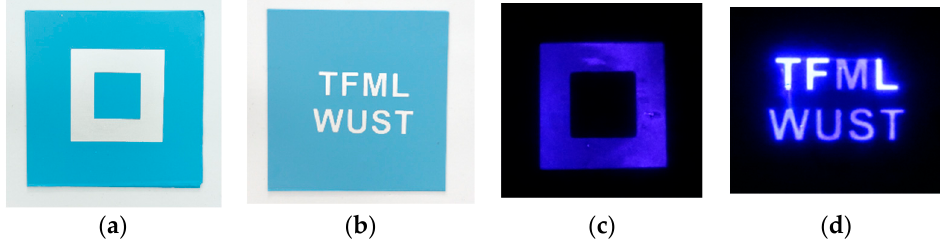
Figure 4. The fidelity of the selective dielectric barrier discharge to the shape of bottom electrodes, deposited on developed structures: ( a ) rectangular electrode, ( b ) letter-shaped electrode, ( c ) rectangular discharge, ( d ) letter-shaped discharge.